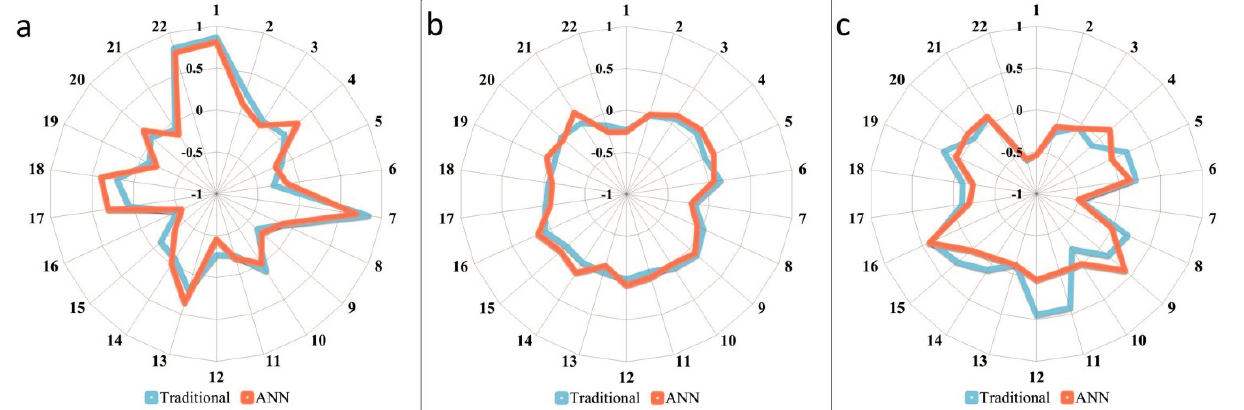
Figure 7. A comparison of the averages of the social variables within the very high ( a ); moderate ( b ); and very low ( c ) vulnerability classes between the traditional SoVI and the ANN-extended